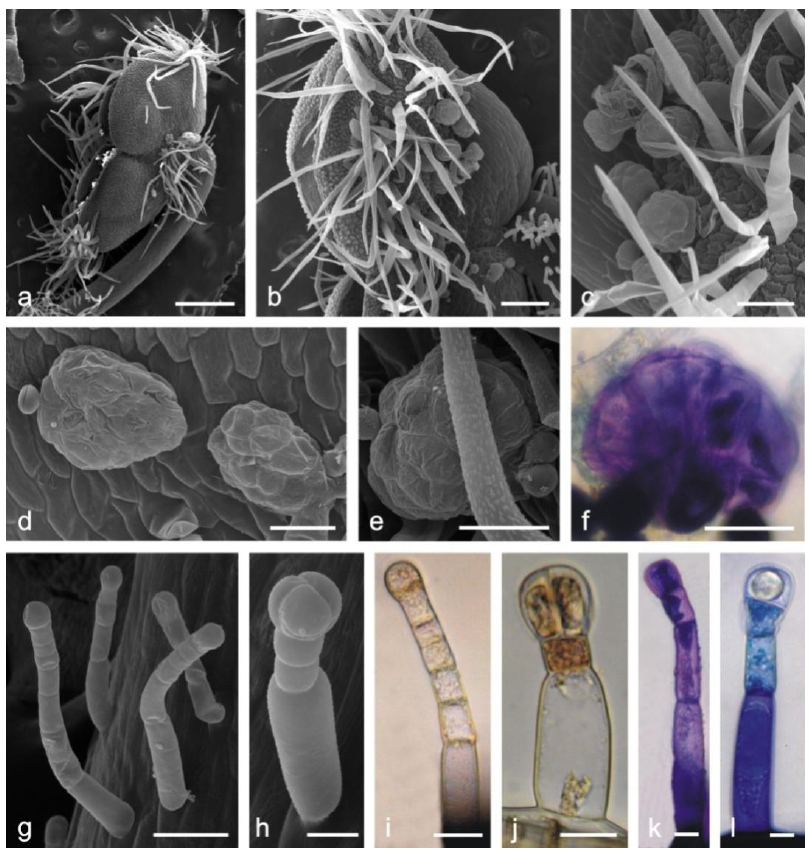
Figure 5. Fragments of L. album subsp. album stamens with various types of trichomes. ( a – e,g – h ) SEM; ( f,l )—LM. ( a – c ) Long non-glandular trichomes and multicellular glandular trichomes anthers. ( d – f ) Multicellular glandular trichomes. ( g – l ) Long-stalked capitate trichomes on filaments.